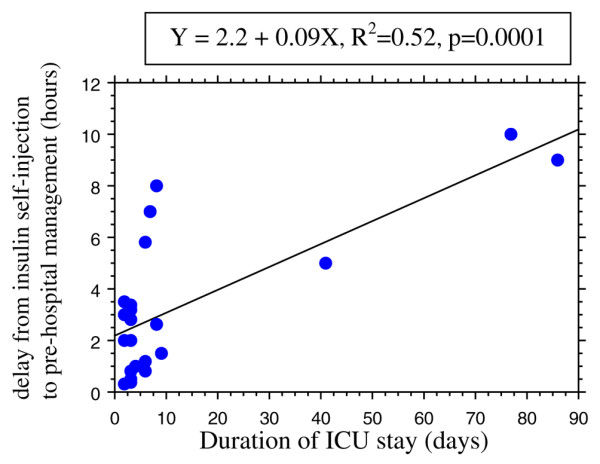
Delay from insulin self-injection to pre-hospital management versus duration of ICU stay. Shown is the correlation between the delay from insulin self-injection to pre-hospital management and the duration of intensive care unit (ICU) stay in 22 cases of insulin self-poisoning.